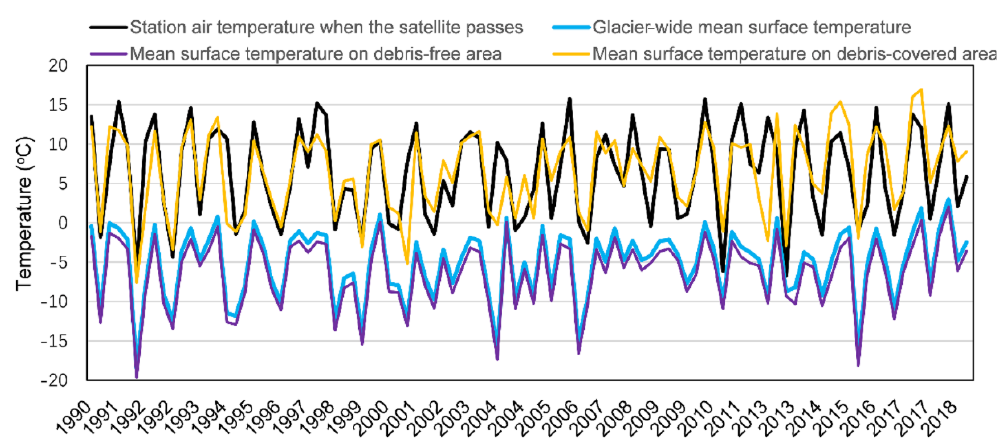
Figure 7. Temporal variation of the station-recorded air temperatures and satellite-derived glacier surface temperatures.